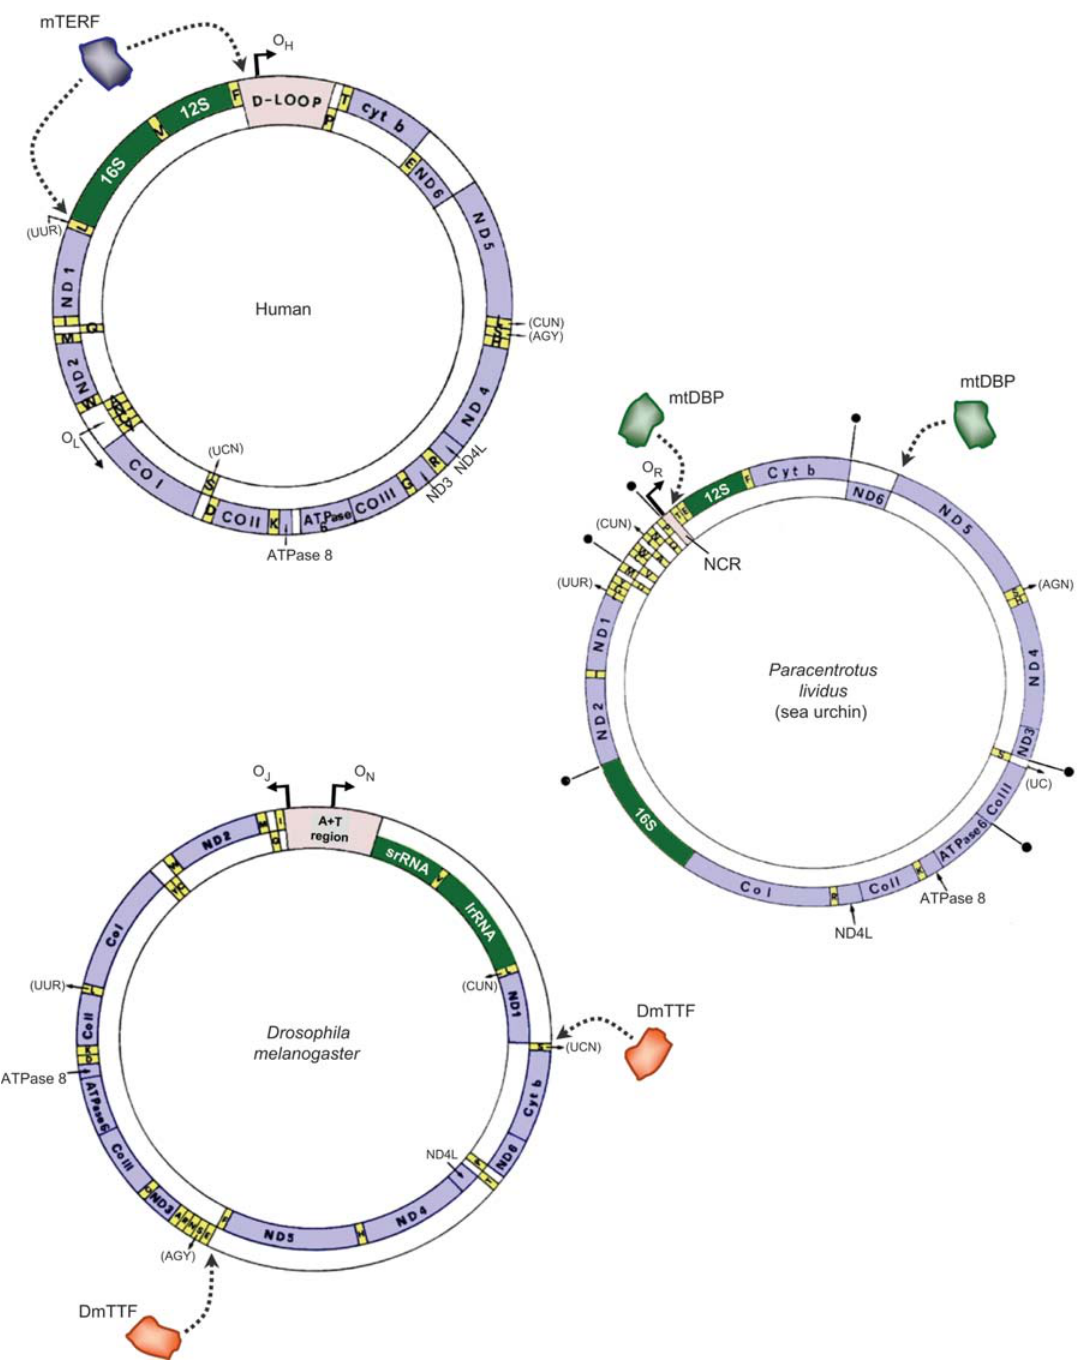
Figure 1 Map of mitochondrial genome in three metazoans, showing the cognate transcription termination factor. Blue, green and yellow: genes encoding the 13 polypeptides of the respiratory complexes, the two rRNAs and the 22 tRNAs, respectively. and O mark the replication origin of H- and L-strand, respectively, according to the conventional strand-asymmetric Human mtDNA: O H L model of mtDNA replication (2). Transcription termination factor mTERF is shown to contact its binding sites. Sea urchin mtDNA: O marks the replication origin of the leading strand (3). Black dots: position of the six small AT-rich sequences, perhaps acting as transcription promoters. Position of the two sites contacted by mtDBP is shown. Drosophila melanogaster mtDNA: O origin of major and minor coding strands, respectively. Transcription termination factor DmTTF is shown to contact its binding sites. The large non-coding AT-rich region (approx. 4.6 kbp) is not to